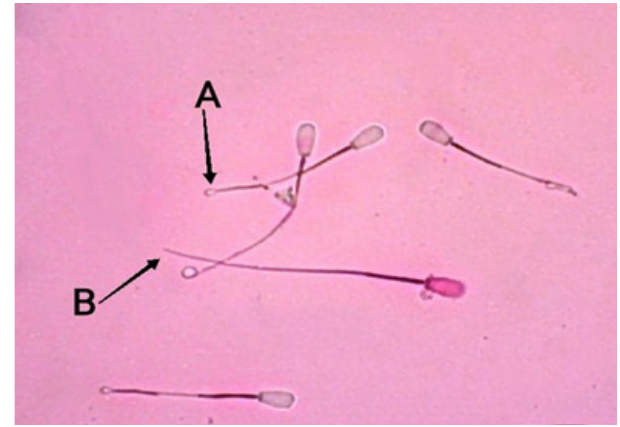
Figure 4. Sperm plasma membrane integrity of Bali bulls as shown by eosin-nigrosin staining under 400× microscope magnification. (A)